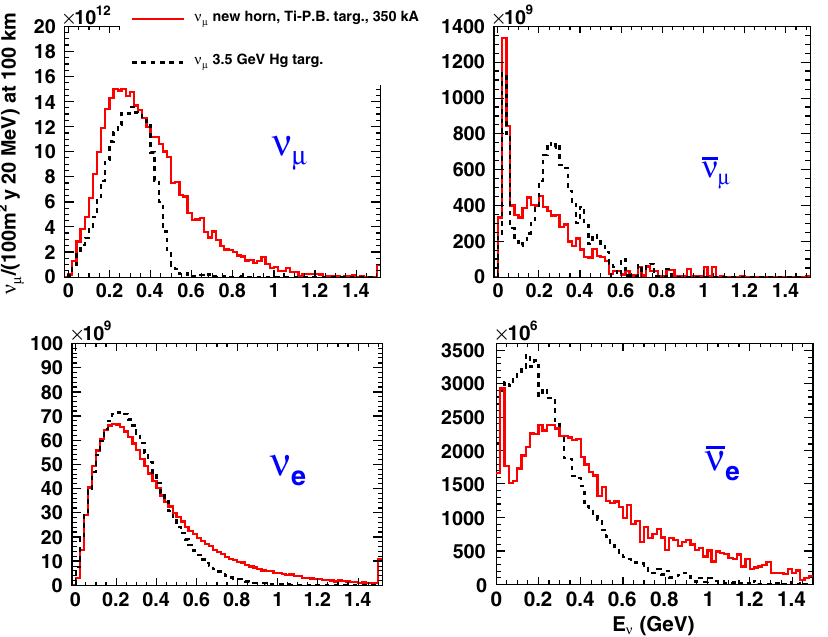
FIG. 30. Comparison of the neutrino fluxes obtained with the new design (continuous line) and the previous one [12] (dotted